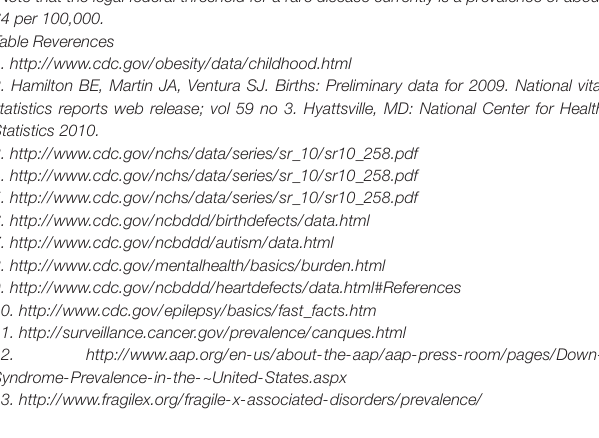
Table Reverences 1.